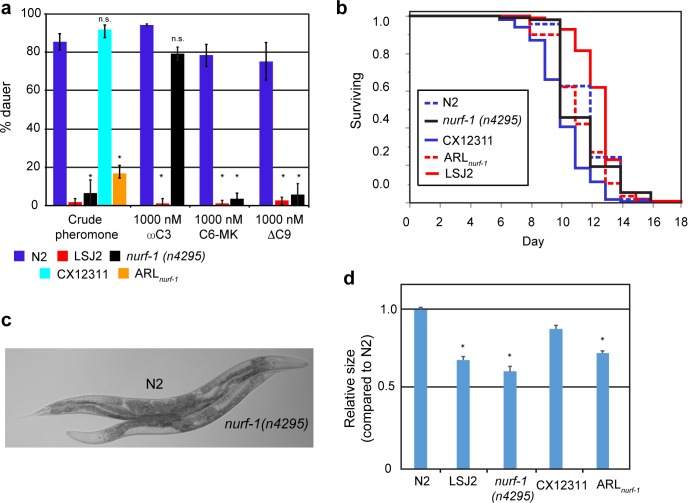
nurf-1 regulates additional life-history traits.a. Dauer formation of the N2, LSJ2, CX12311, ARLnurf-1, and nurf-1(n4295), strains in response to crude pheromone or N2, LSJ2, and nurf-1(n4295) in response to synthesized pheromone components. y-axis indicates the percentage of animals that enter dauer in response to the pheromone concentrations listed on the x-axis averaged from at least fiver replicates. Stars indicate significant differences (p<0.05) from the N2 strain. b. Lifespan analysis of the N2, LSJ2, CX12311, ARLnurf-1 and nurf-1(4295) animals. At least three independent replicates containing ~60 worms were used for this analysis. The LSJ2 and ARLnurf-1 strain were both significantly different (p < 0.05) than CX12311. The nurf-1(4295) strain was not significantly different from the N2 strain. c. Micrograph comparing the size of N2 and nurf-1(n4295) animals. Embryos were isolated from each strain and allowed to hatch and grow on agar plates for 72 hours. d. Growth rate of N2, LSJ2, CX12311, ARLnurf-1 and nurf-1(n4295) strains. y-axis shows the average area of each animal measured by videotracking normalized to the N2 strain. Three independent growth plates were analyzed each day and three replicates were performed on different days. Their size was measured 72–75 hours after isolation. Stars indicate significant differences (p<0.05).